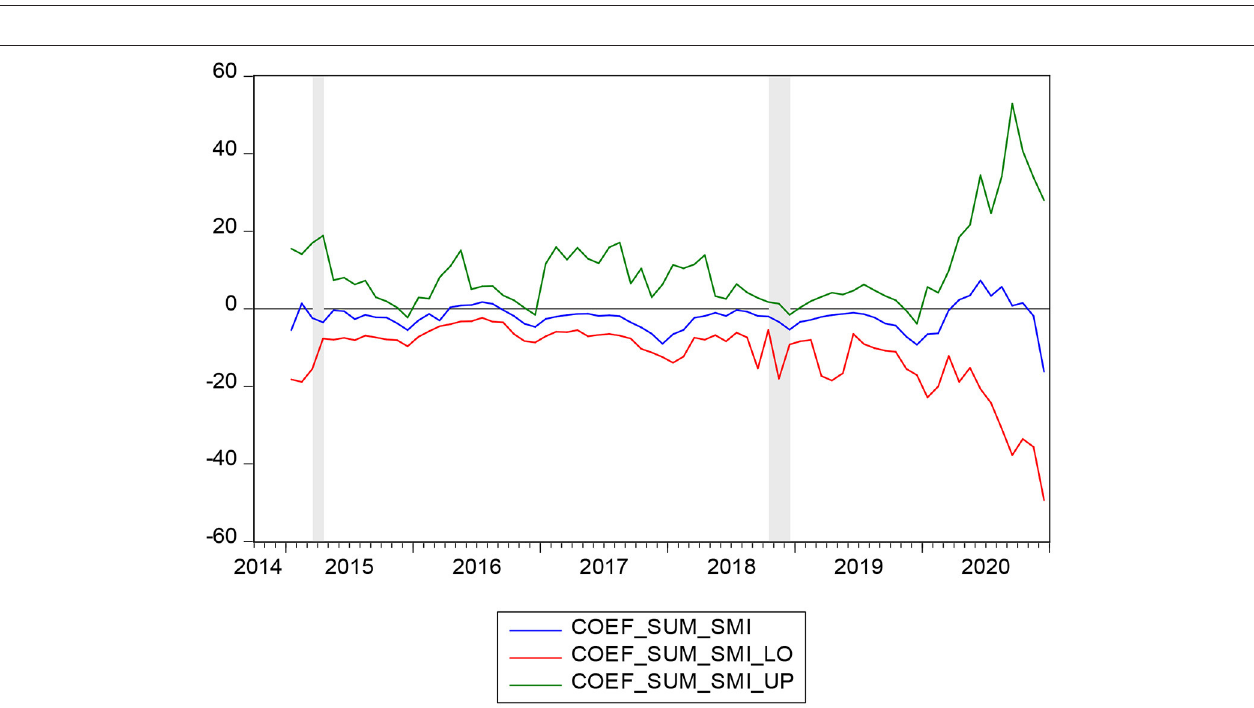
FIGURE 3 | The bootstrap p -value of the rolling test statistic testing the null that PR does not Granger cause SMI.